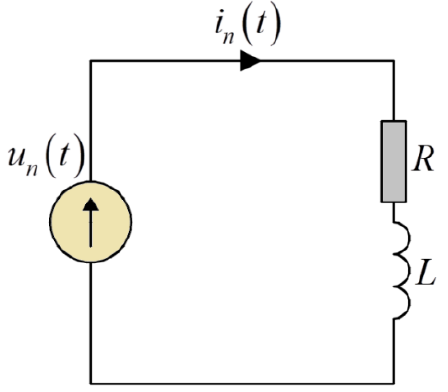
Figure 2. Scheme of the single-phase system used for theoretical calculations.